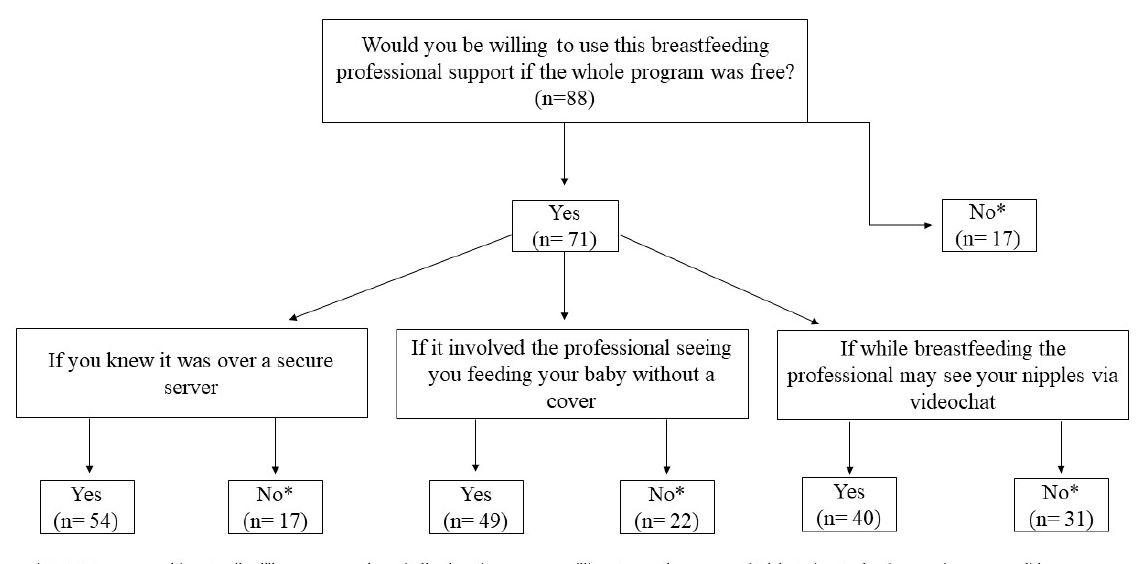
Figure 2. Conditions under which mothers would be willing to use telelactation services if it were free.